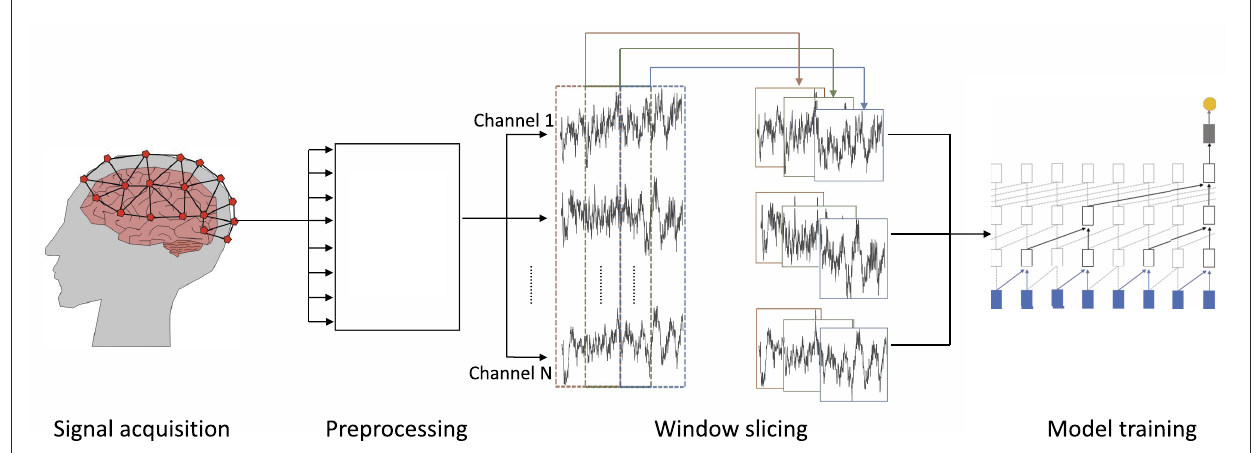
training—on the windowed and preprocessed wave